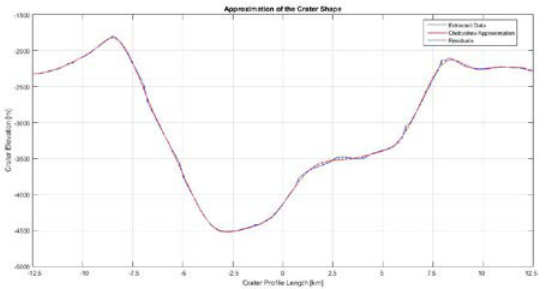
Figure 4. - Example of interpolation of a lunar crater cross- sectional profile using Chebyshev